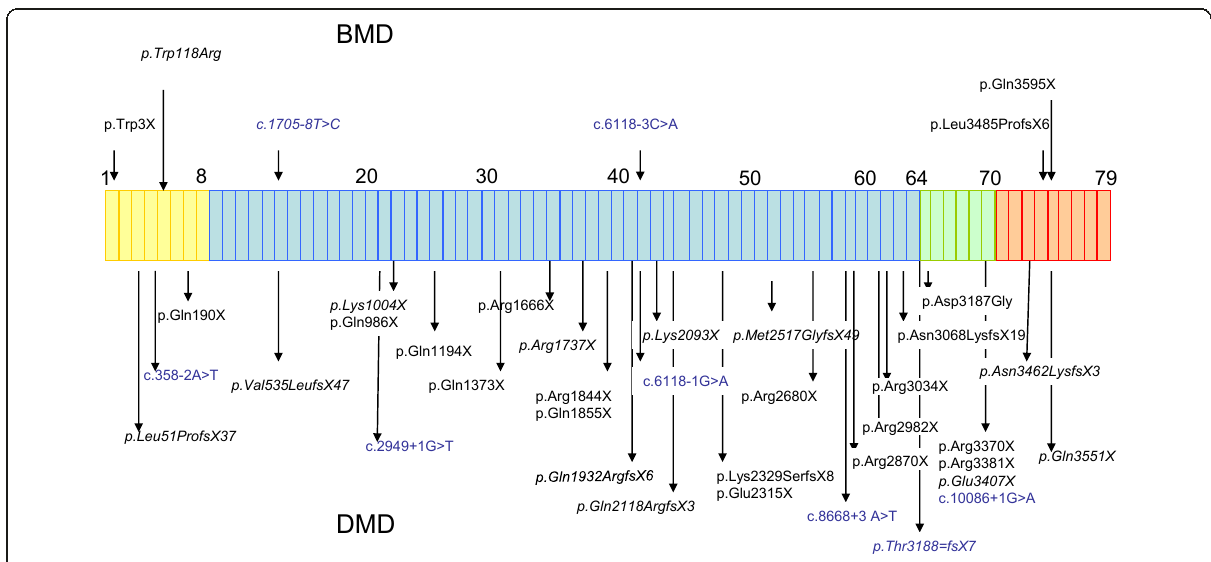
Figure 1 Distribution of mutations along the DMD gene . Each box corresponds to an exon, with different colours indicating the four different functional portions of the gene: actin-binding domain (exons 1-8, yellow); rod domain (exons 9-62, blue); cysteine-rich domain (exons 63-69, green); C-terminal domain (exons 70-79, red). Mutations identified in the BMD population are listed in the upper part of the figure, while mutations found in the DMD population are listed in the lower section. Intronic mutations are listed in